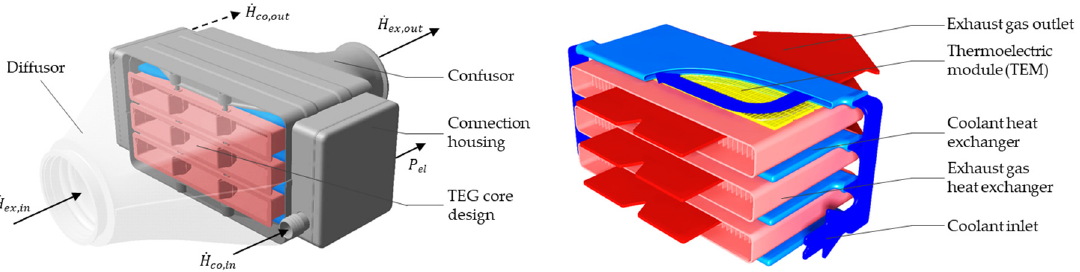
Figure 3. Principle illustration of the highly integrated TEG stack architecture (counter flow heat exchanger design) with objective TCO min for the natural gas HDV. Table 2. Thermoelectric module characteristics related to this work of the manufacturer LG Chem.